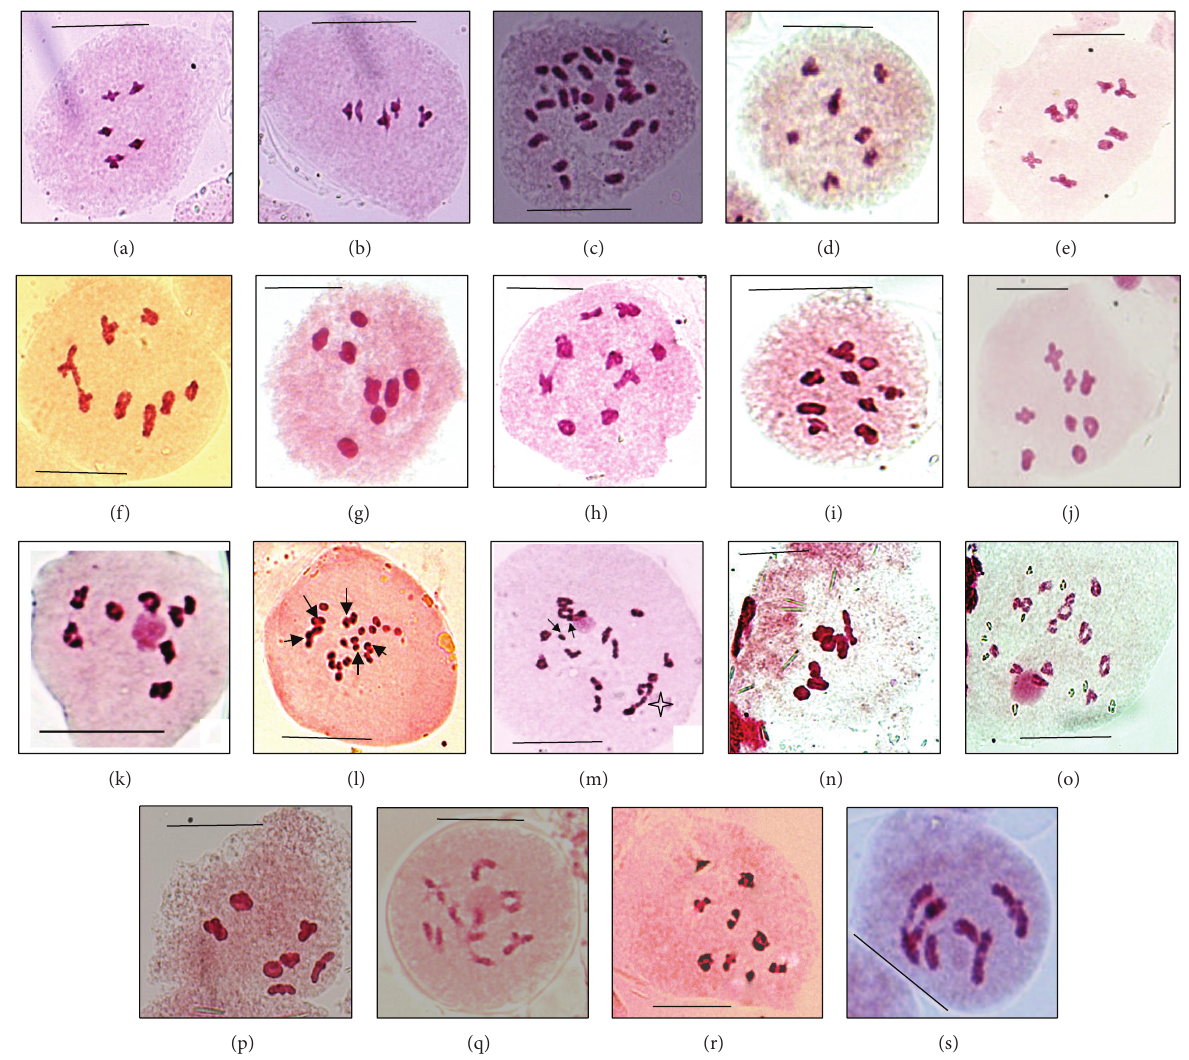
Figure 1: (a) Hieracium crocatum , PMC showing 5II at M-I. (b-c) H. umbellatum : (b) diploid cytotype, PMC showing 5II at M-I, (c) hexa- ploid cytotype, PMC showing 27II at diakinesis. (d) Lactuca dissecta , A PMC showing 8II at M-I. (e) L. dolichophylla , PMC showing 8II at M-I. (f) L. lessertiana , PMC showing 8II at M-I. (g) L. macrorhiza , PMC showing 8II at M-I. (h) L. sativa , PMC showing 9II at M-I. (i) L. serriola , PMC showing 9II at M-I. (j) Prenanthes brunoniana , PMC showing 8 bivalents at M-I. (k–m) Taraxacum officinale : (k) diploid cytotype, PMC of diploid cytotype showing 8II at diakinesis, (l) triploid cytotype, PMC showing 5II + 14I at M-I (bivalents with arrow), and (m) tetraploid cytotype, PMC showing 1IV + 13II + 2I (univalents with arrow and quadrivalent with star). (n-o) Tragopogon dubius : (n) diploid, PMC showing 7II at M-I, (o) tetraploid cytotype, PMC showing 14II at diakinesis. (p) T. gracilis , PMC showing 7II at M-I. (q) Youngia glauca , PMC showing 7II at diakinesis, (r) Y. japonica , PMC showing 8II at M-I. (s) Y. tenuifolia , A PMC showing 5II at